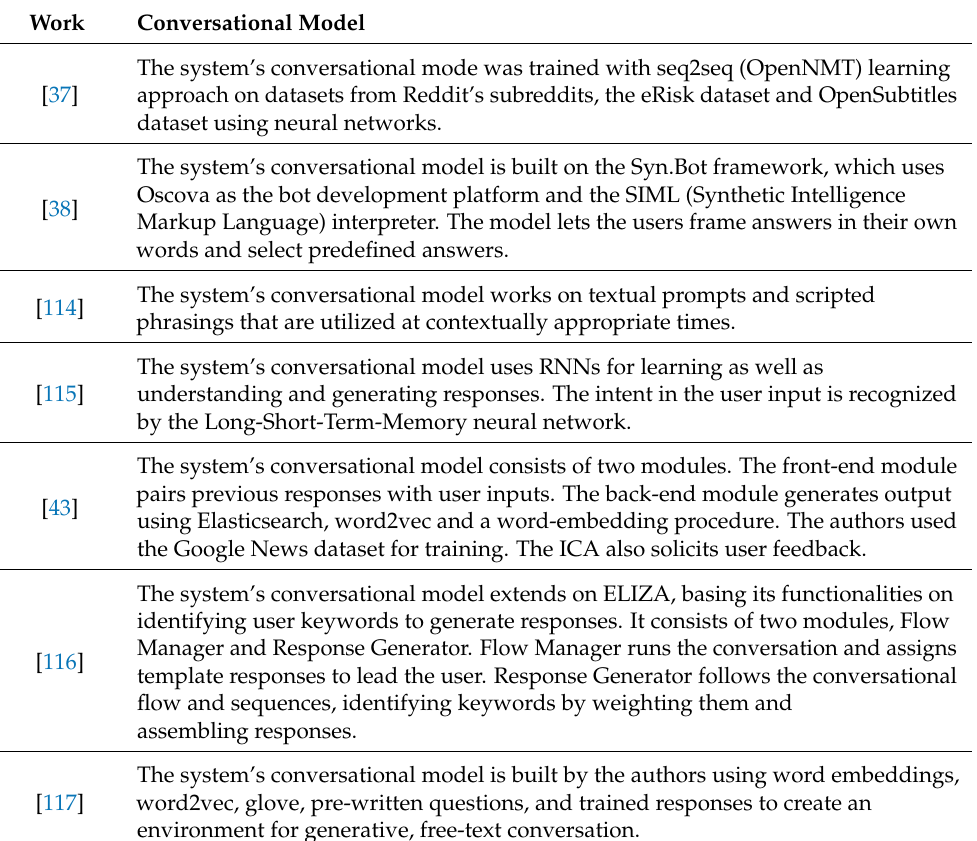
Table 4. Answering RQ3. What are the technical aspects of the conversational models in the